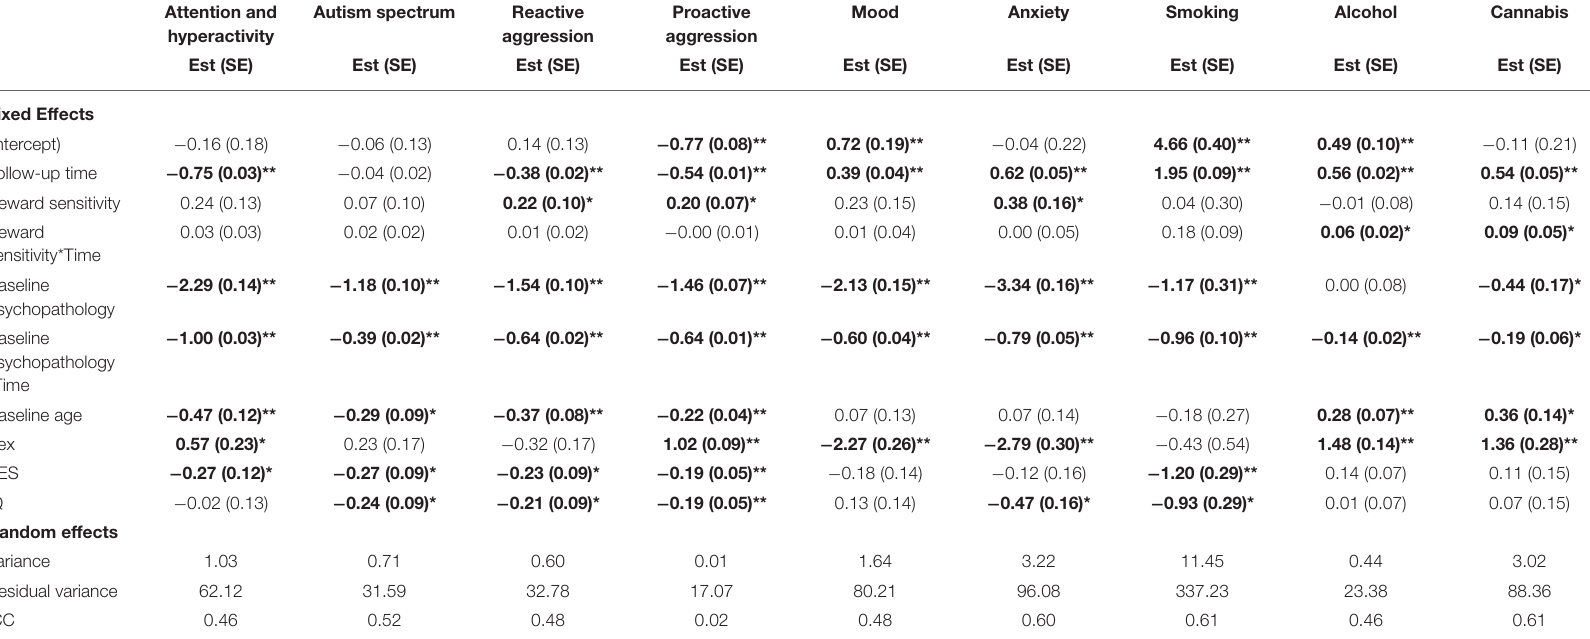
TABLE 3 | Multilevel growth curve model estimates for all psychopathology